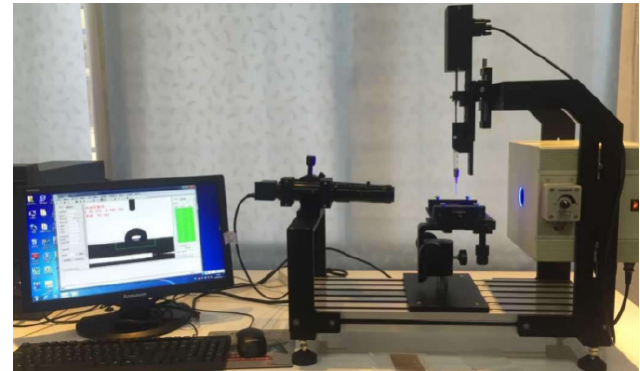
Figure 3. Contact angle tester, which consists of three parts: an automatic injection system, a charge-coupled device (CCD) camera, and an automatic image analysis system.